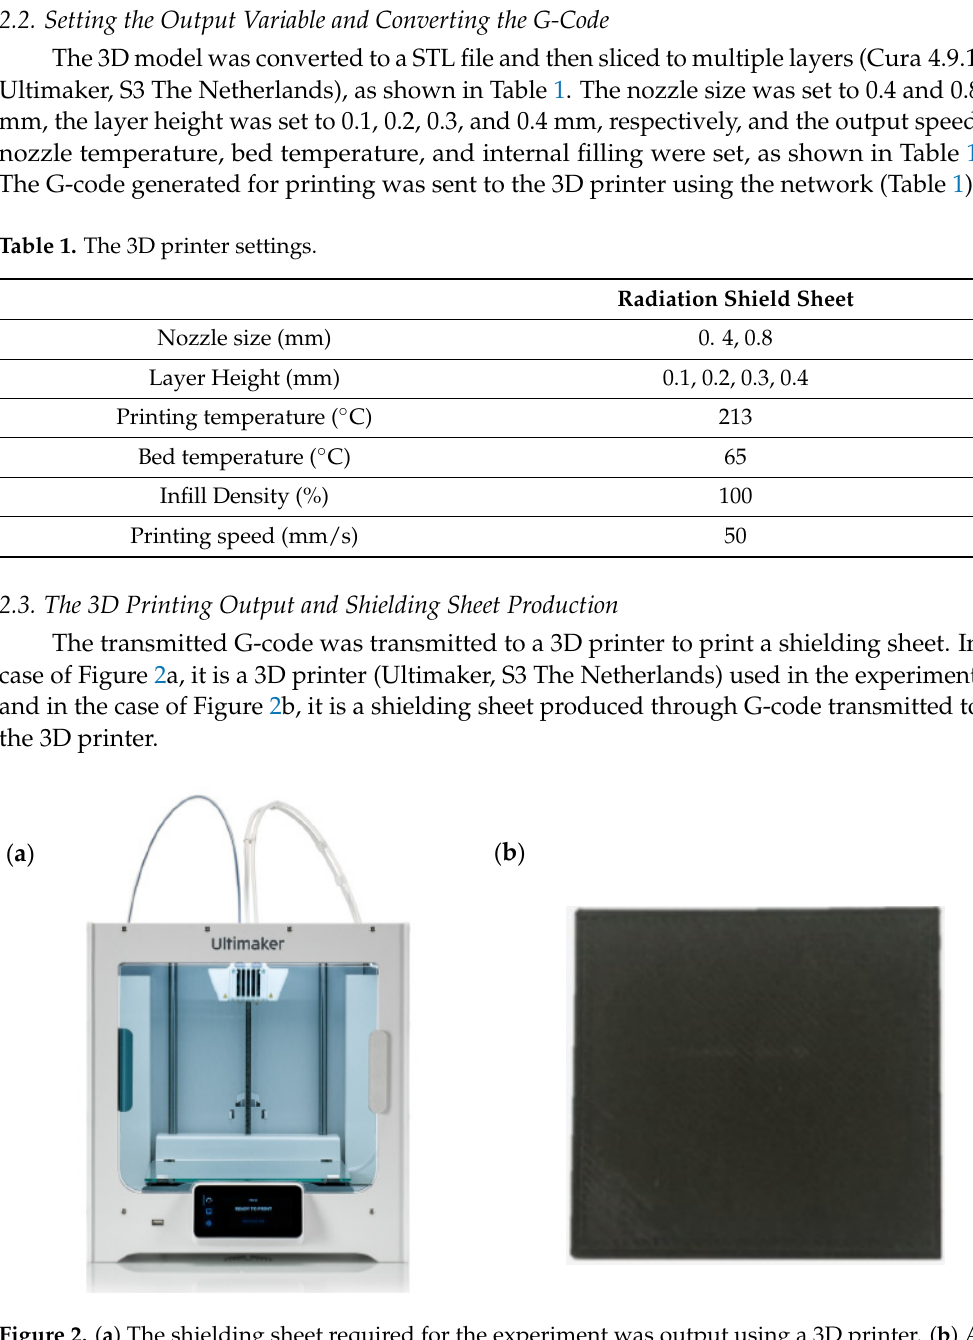
Figure 2. ( a ) The shielding sheet required for the experiment was output using a 3D printer. ( b ) A shielding sheet was manufactured using a tungsten mixed filament (Tungsten +